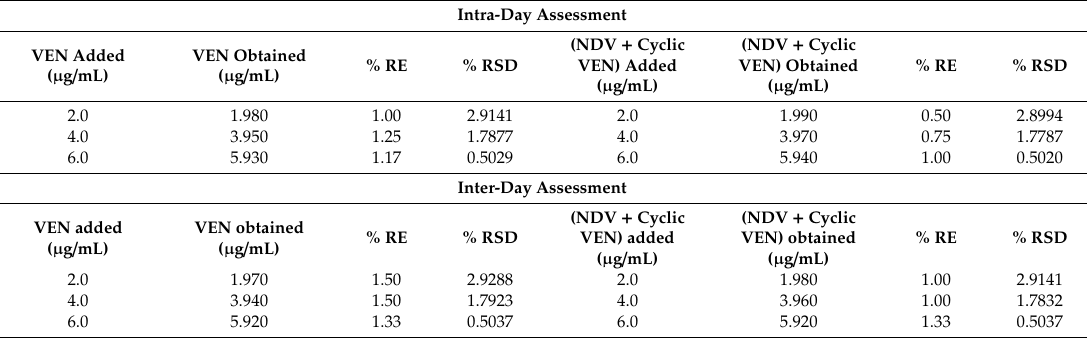
Table 2. Recovery studies of VEN and NDV + Cyclic VEN.